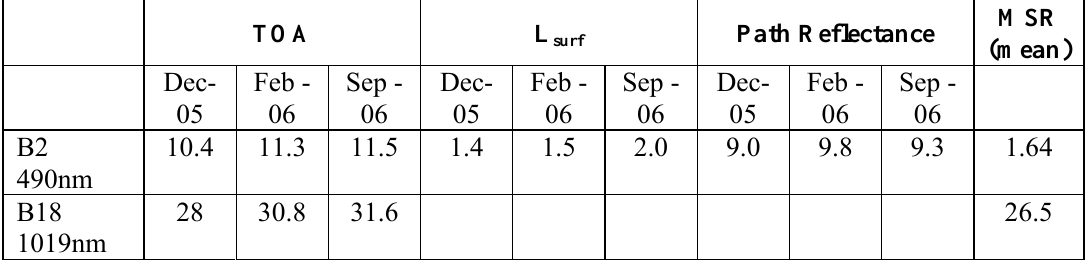
Table 2 . Image reflectance (%): (TOA), Surface reflectance (L reflectance for CHRIS 490 nm, 661 nm and 1,019 nm bands (mean values from training areas). MSR values were recorded between October and December